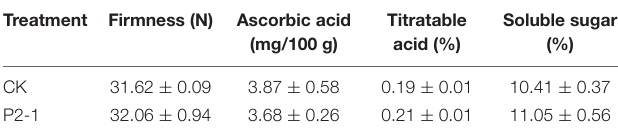
TABLE 2 | Effects of B. velezensis strain P2-1 on postharvest quality parameters of apple. Treatment Firmness (N) Ascorbic acid (mg/100 g)